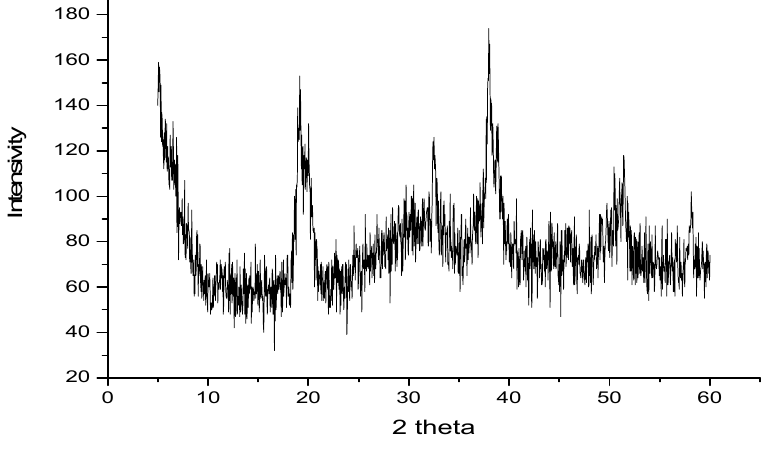
Figure 1. The XRD pattern of Co-Zr LDH.